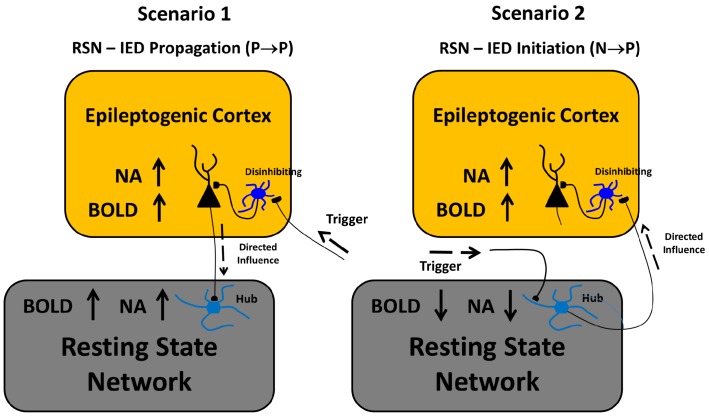
Scenarios.Two possible scenarios by means of which the resting-state network and the irritative zone network might be intrinsically related. A mechanistic explanation for the directed influences among elements from the irritative zone network are provided. NA = neuronal activity; BOLD = blood-oxygen-level dependent; IED = interictal epileptiform discharge; RSN = resting-state network.